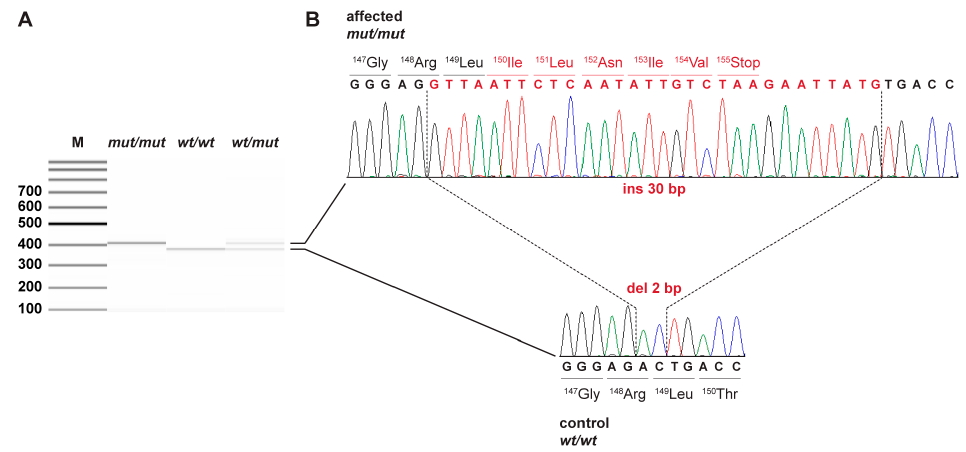
Figure 1. Details of the ACADM: c.444_445delinsGTTAATTCTCAATATTGTCTAAGAATTATG variant. ( A ) Fragment Analyzer bands of PCR products from samples of all three genotypes show the expected 28 bp difference in length of the wild type and mutant products. ( B ) Sanger sequencing electropherograms of the dog affected by MCAD deficiency (top) and a control dog (bottom) illustrate the deletion of 2 bp with simultaneous insertion of 30 bp in exon 6 of the ACADM gene. Altered nucleotide and amino acid sequences are indicated in red. We genotyped the variant in a cohort of 162 CKCS that were not closely related to the index case and sampled during an independent study (Table 2). This experiment re- vealed 52 heterozygous carriers and 12 homozygous mutant dogs. The genotype distribu- tion did not significantly deviate from Hardy–Weinberg equilibrium. The frequency of the putative disease allele was 23.5% in the investigated CKCS population. Table 2. Genotype distribution at the ACADM frameshift variant in 162 CKCS.